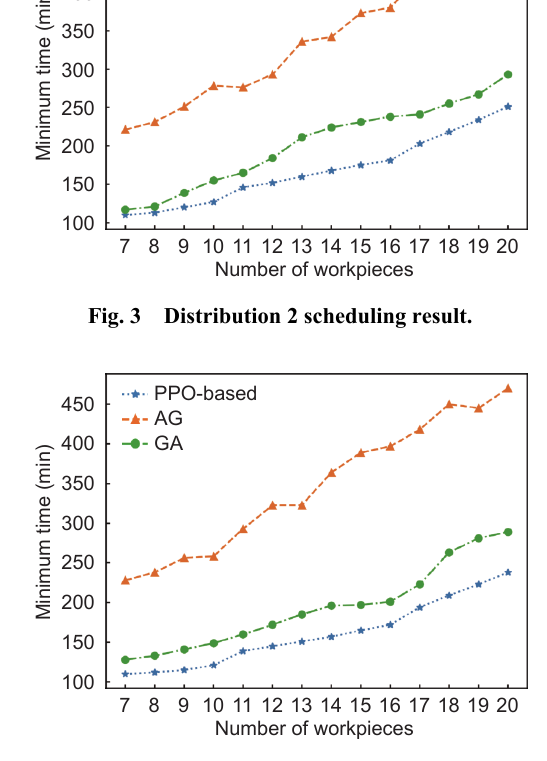
Fig. 4 Distribution 3 scheduling result.